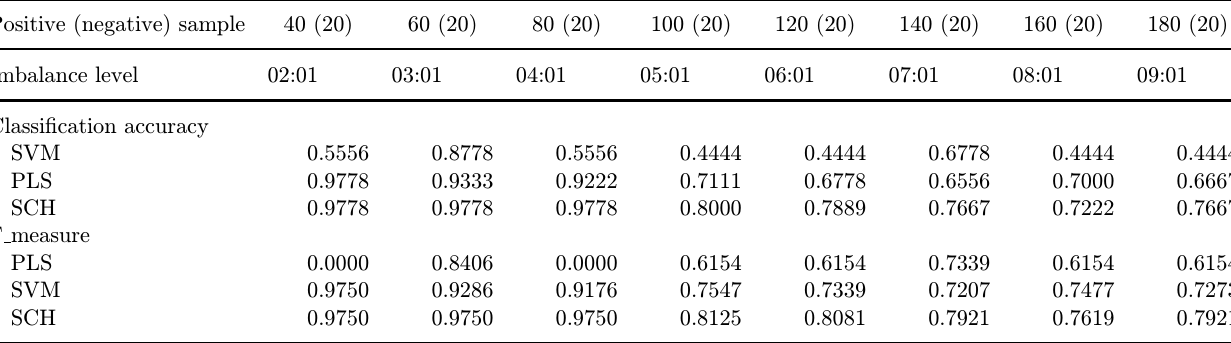
Table 5. Classi¯cation accuracy table for the active substance on pharmaceutical tablets dataset.